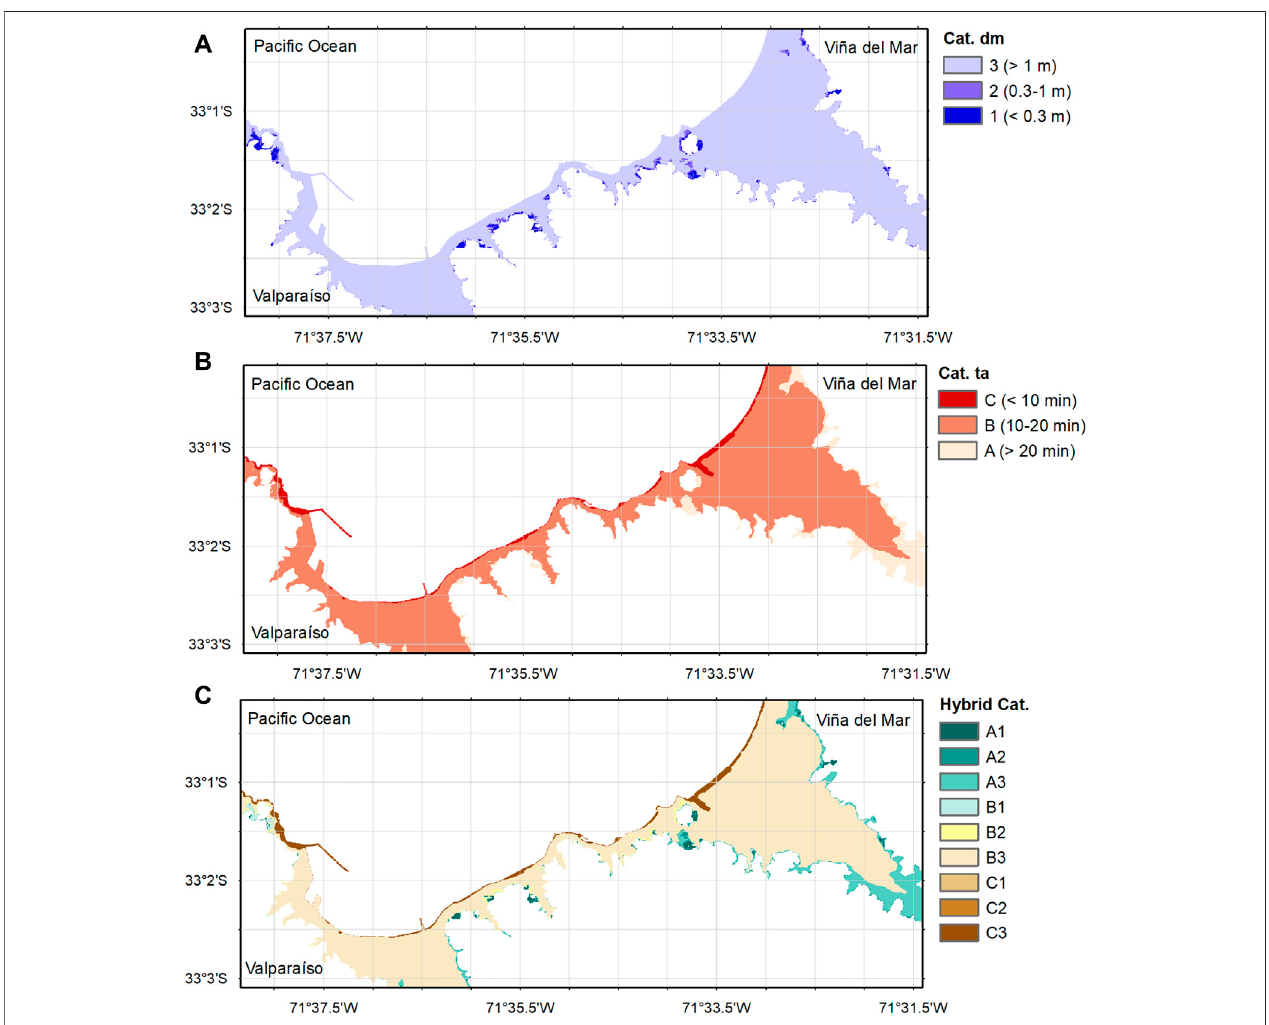
FIGURE6| Applicationofcategorizationthresholdstoqualifyhazard (A) Hazardlevelsbasedontsunami fl owdepth (B) Hazardlevelsbasedontsunamiarrivaltime (C) Hybrid categorization hazard levels. Thresholds for each case are de fi ned in Table 1 . Refer to Fig. S10 in the Supplementary Material where the fraction of events in each hazard level is shown, and Figs. S11-S17 to see the categorization for each Mw.